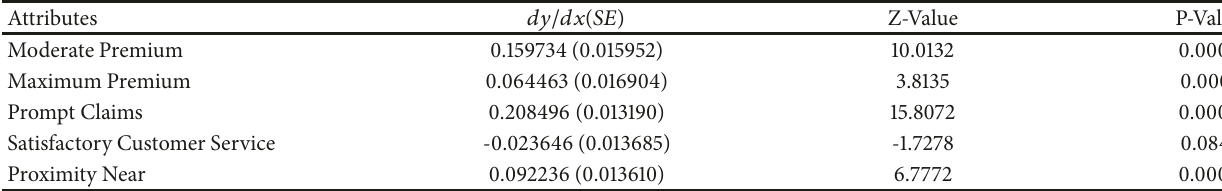
Table 5: Marginal effects of full model.